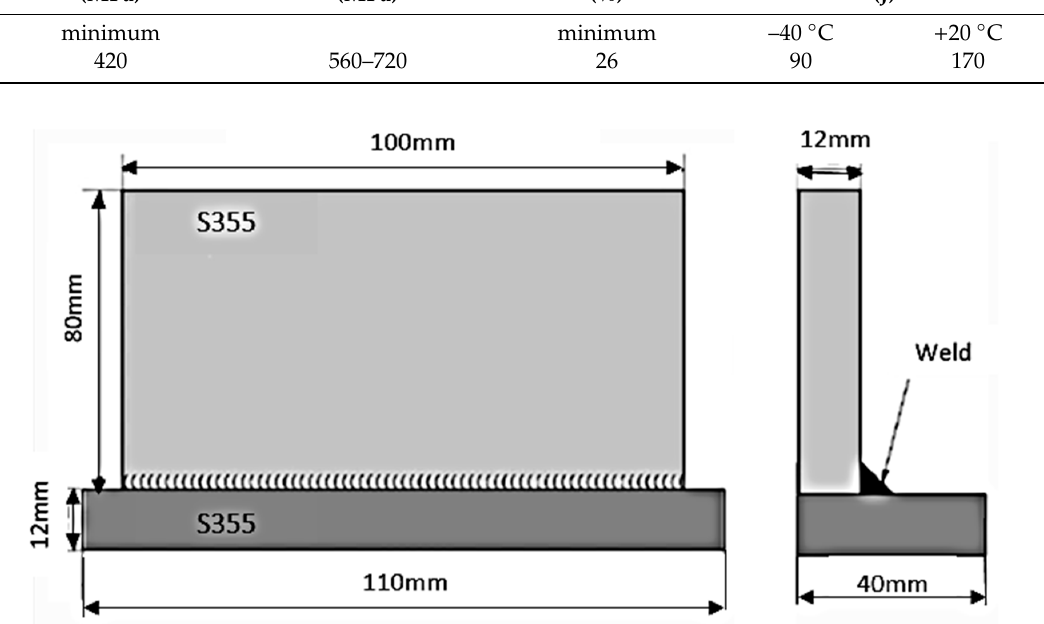
Figure 1. Shape and dimensions of samples.